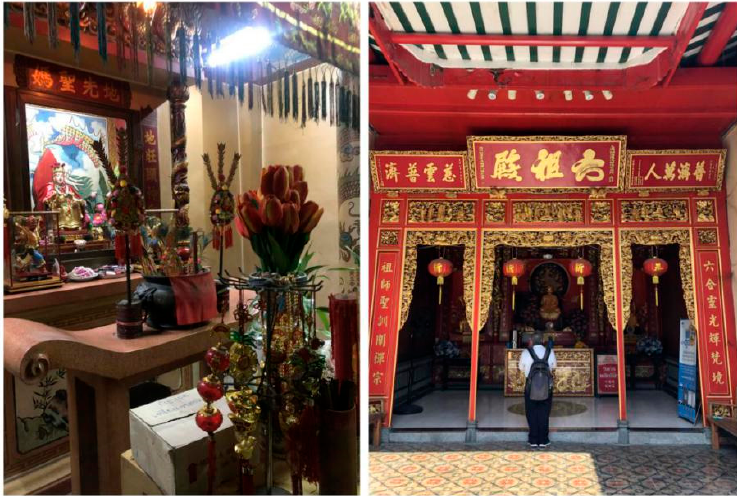
Figure 3. Chinese traditional folk arts and crafts in Thai-Chinese temples.